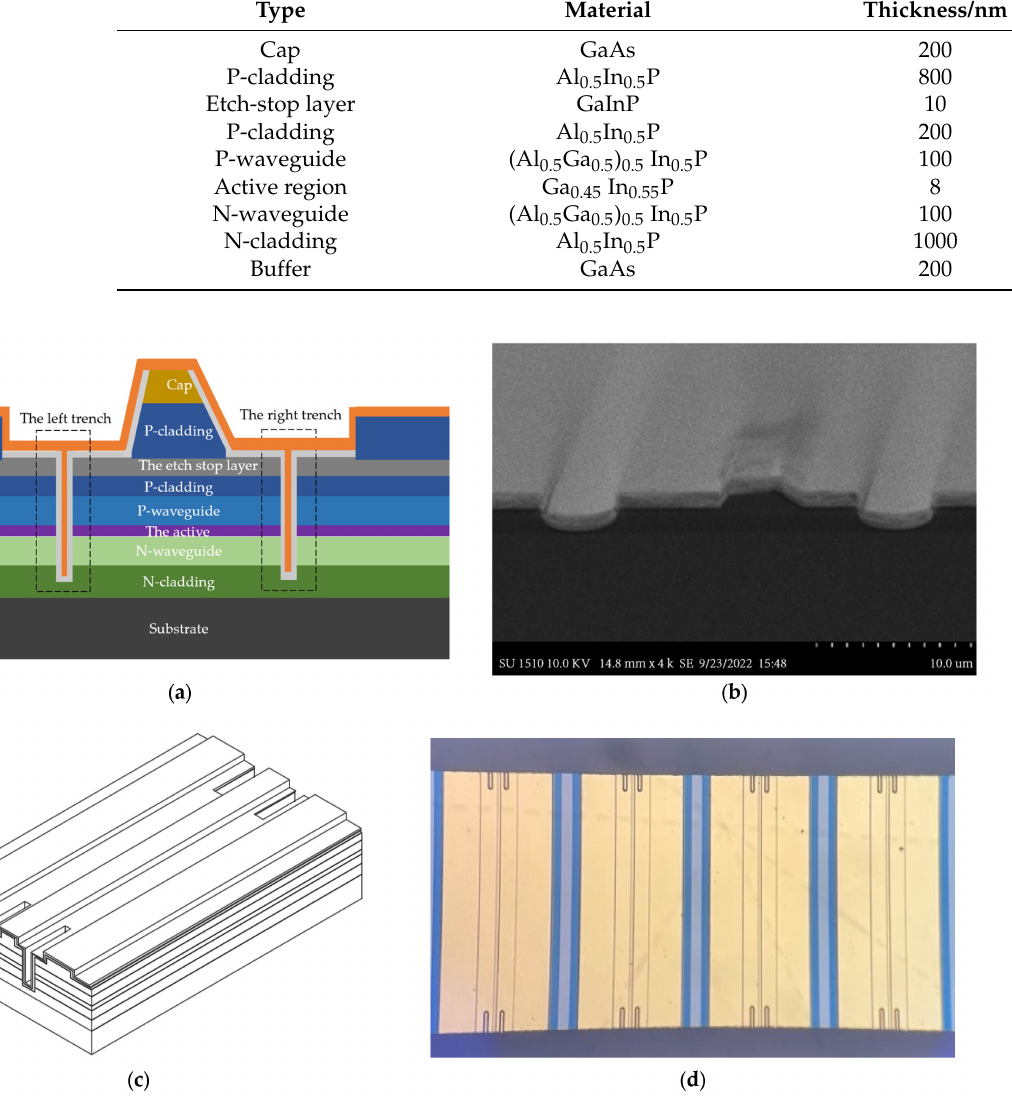
Table 1. Design parameter of epitaxial structures.